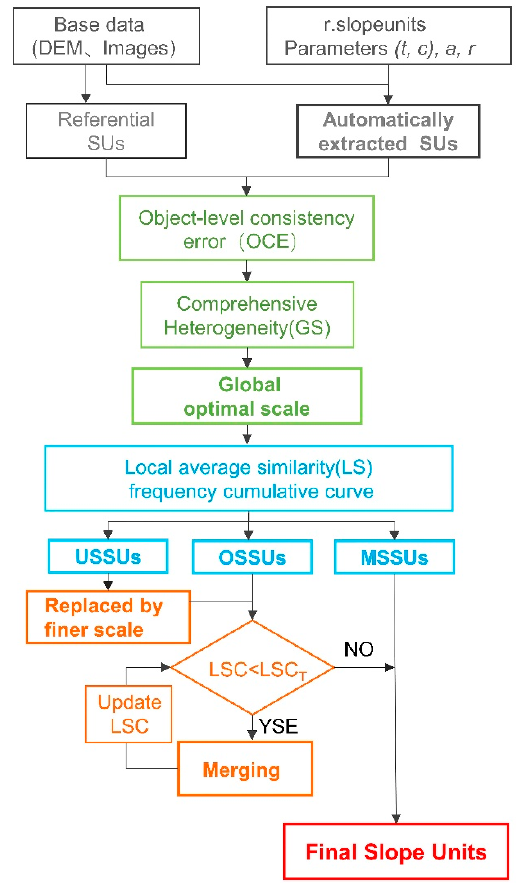
Figure 4. Flow diagram of the proposed assessment and local multi-scale optimization